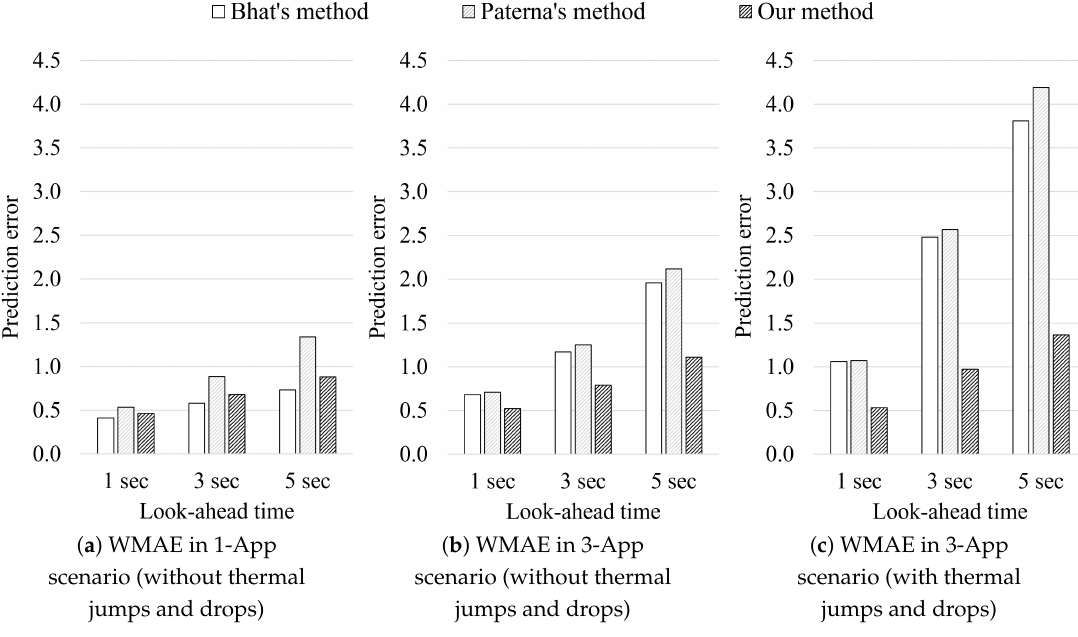
Figure 18. Accuracy comparison of three thermal prediction